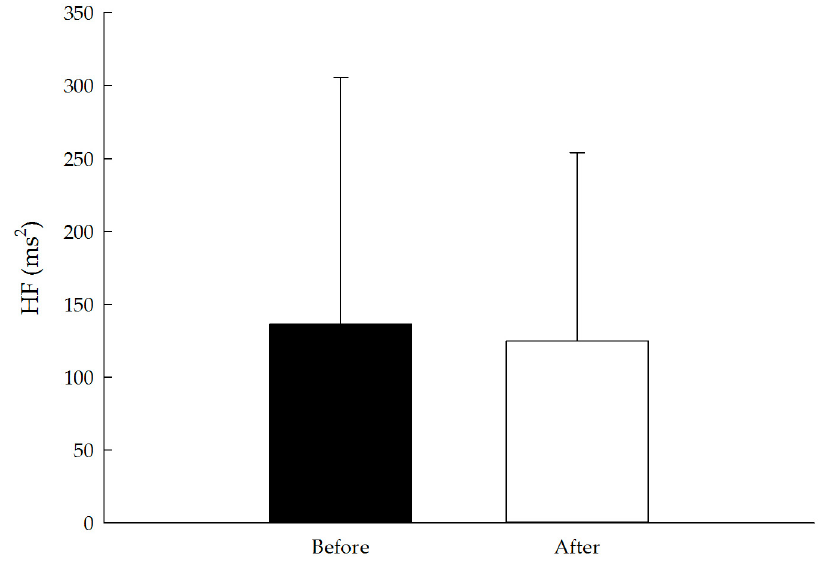
Figure 4. Effect of the short forest bathing program on HF. N = 128, mean ± standard error. Paired-sample t test.